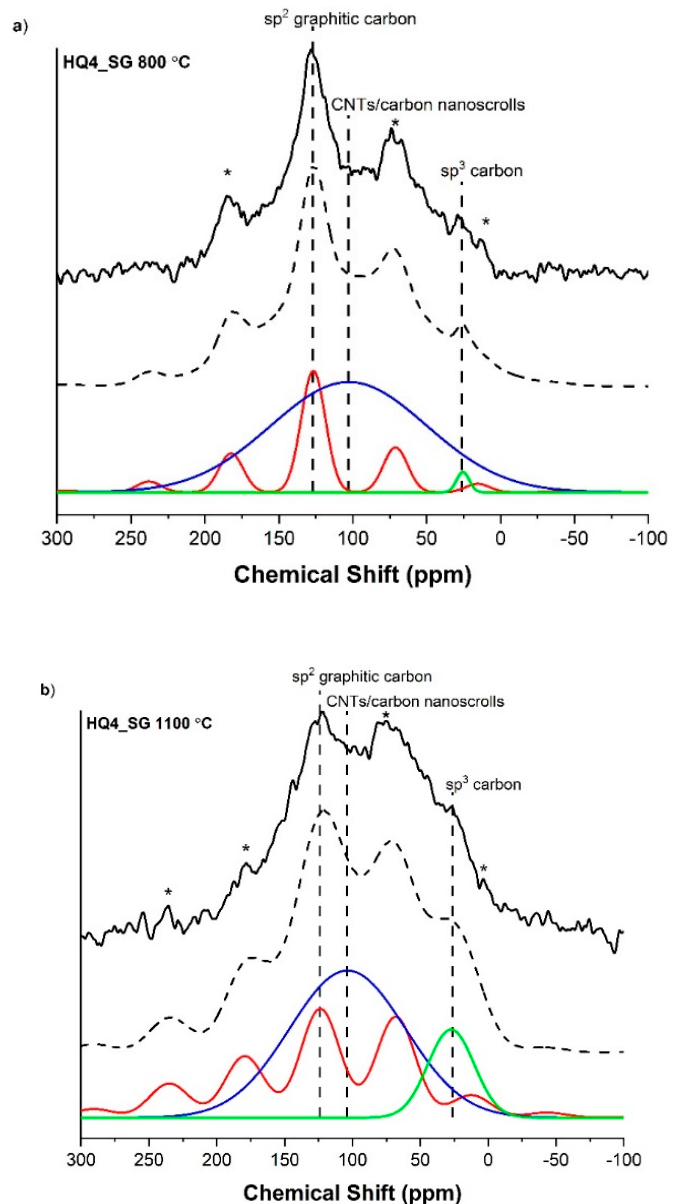
Figure 8. 13 C( 1 H) CPMAS NMR of the HQ4_SG samples with isotropic peaks at ~127 ppm, 103 ppm and 26 ppm, corresponding to sp 2 hybridized graphitic carbon, CNT/carbon nanoscrolls and sp 3 hybridized carbon, respectively; for ( a ) the sample pyrolyzed to 800 °C and ( b ) the sample pyrolyzed at 1100 °C. The stars * denote spinning side bands.